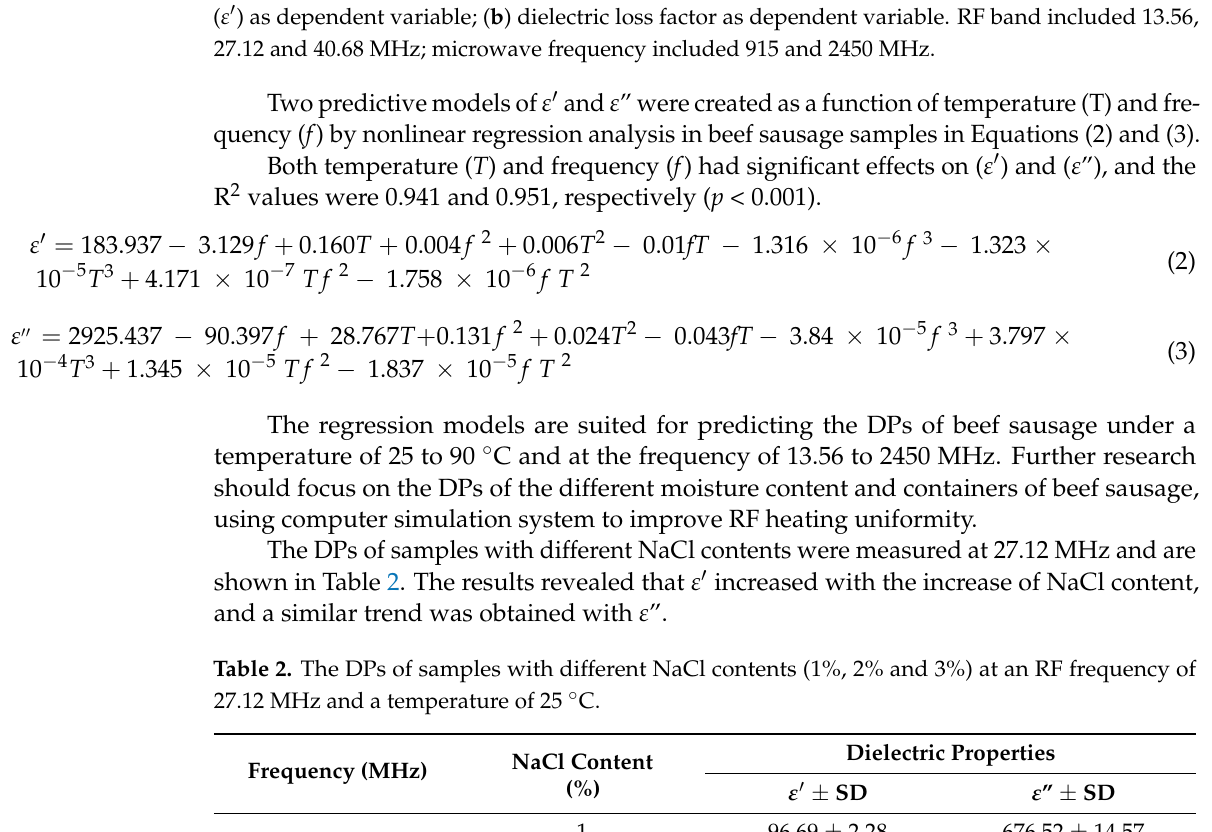
Table 2. The DPs of samples with different NaCl contents (1%, 2%and 3%) at a RF frequency of 27.12 MHz and a temperature of 25 °C.